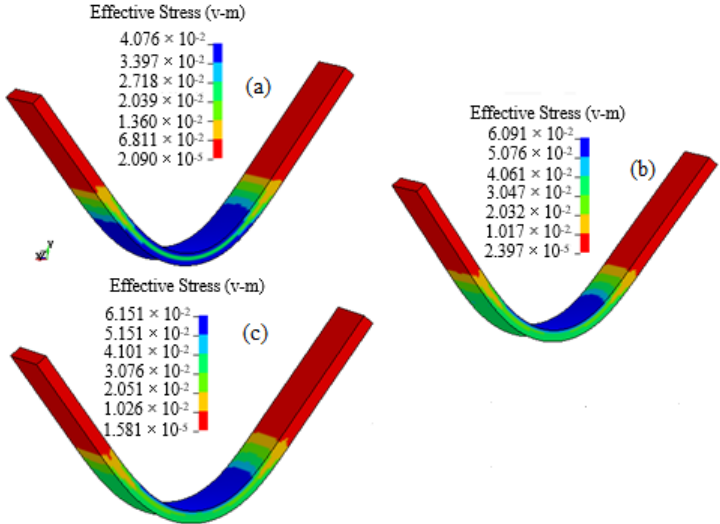
Figure 12. Von-Mises stress contour plots, ( a ) Von-Mises, ( b ) Drucker–Prager, and ( c ) SAMP-1 yield surfaces (deformation rate: 0.5 mm/s).